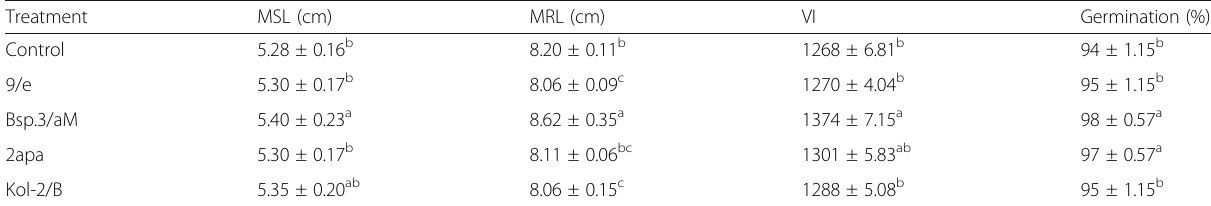
Table 3 Efficacy of seed biopriming on seedling vigor